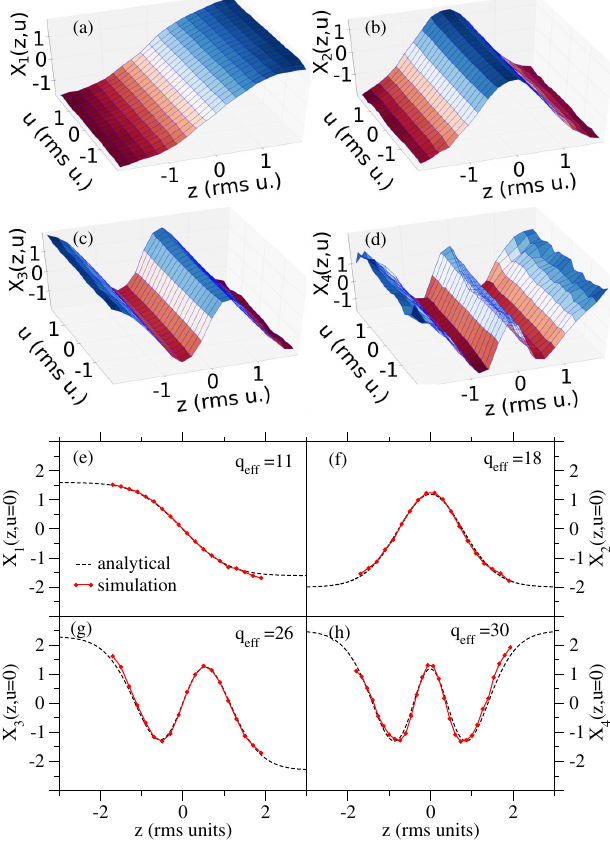
FIG. 1. The first four modes of a 3D-G bunch in the strong space charge regime. (a) – (d) At large q the modes ’ spatial eff distribution is nearly independent of u , i.e., X ð z; u Þ ≈ Y ð z Þ , as predicted by Ref. [6]. (e) – (h) Comparison of the simulated modes (solid red) with the theoretical space charge harmonics (dashed black) [6]. The agreement is very